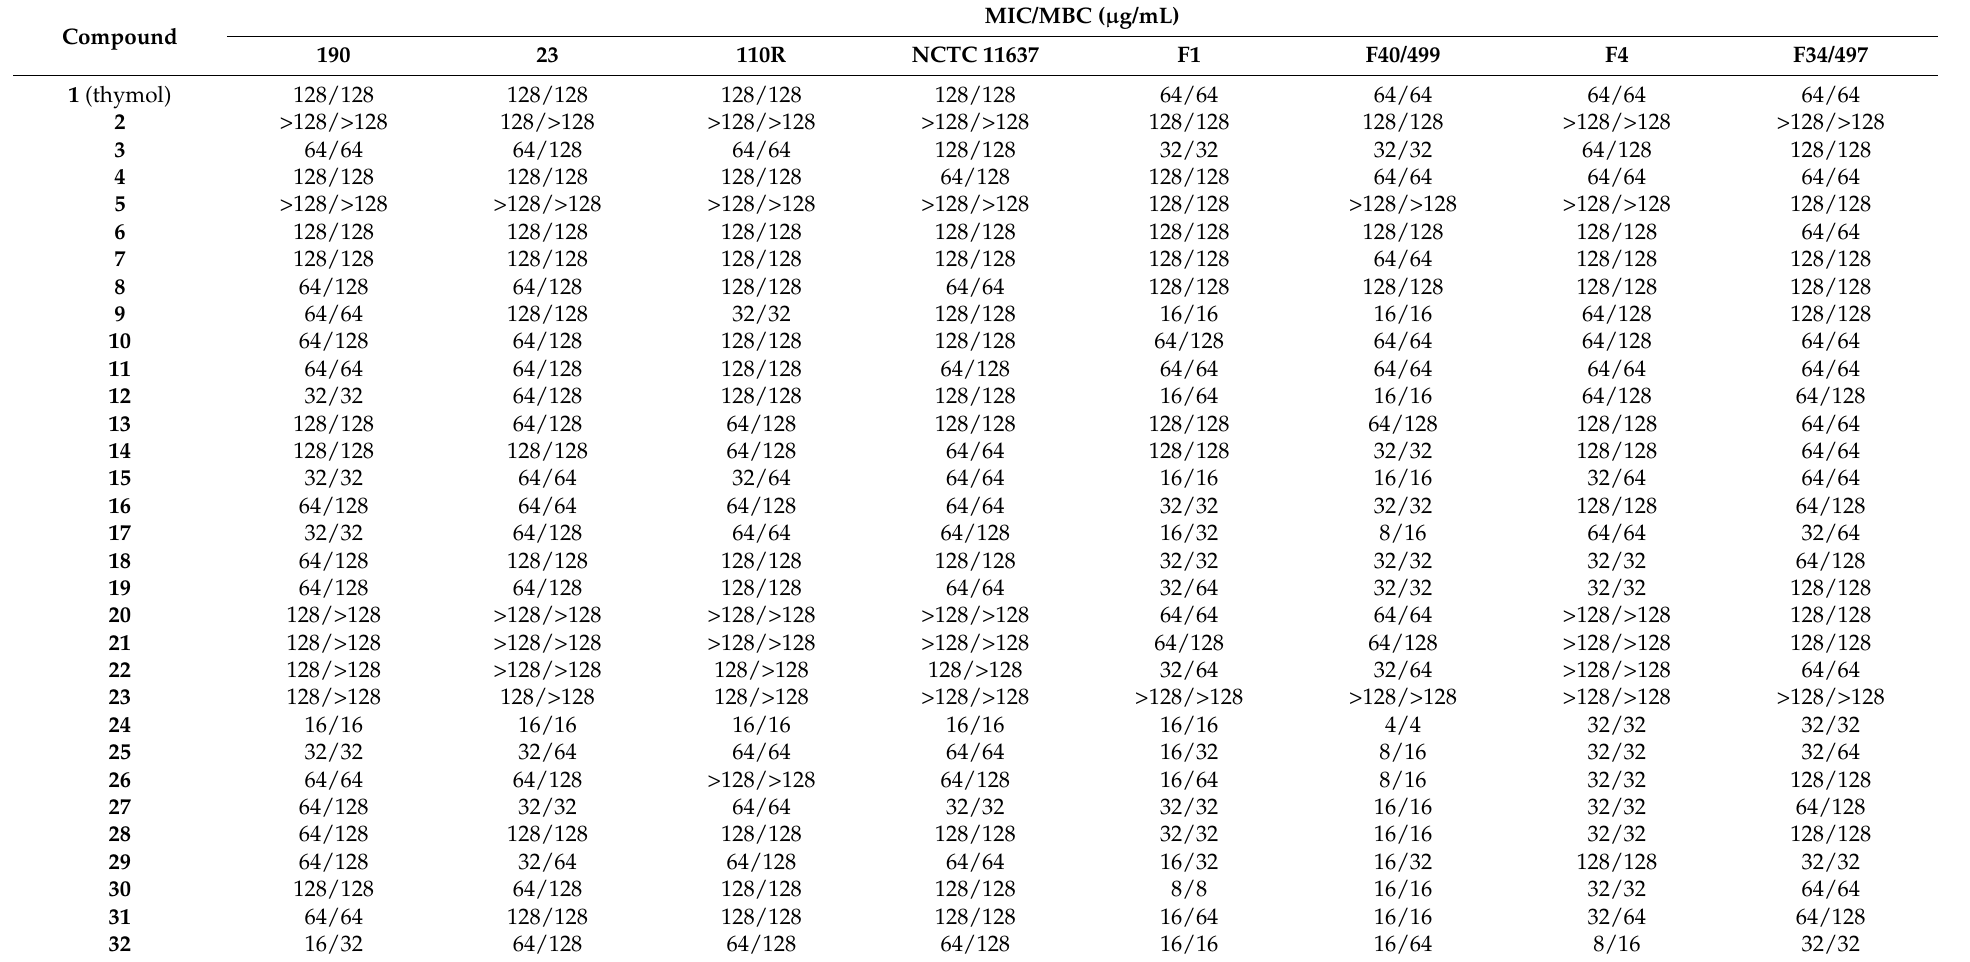
Table 1. MIC and MBC values for thymol ( 1 , parent compound), its semi-synthetic derivatives ( 2 – 39 ), and carvacrol against eight strains of H. pylori . Antibiotic susceptibility according